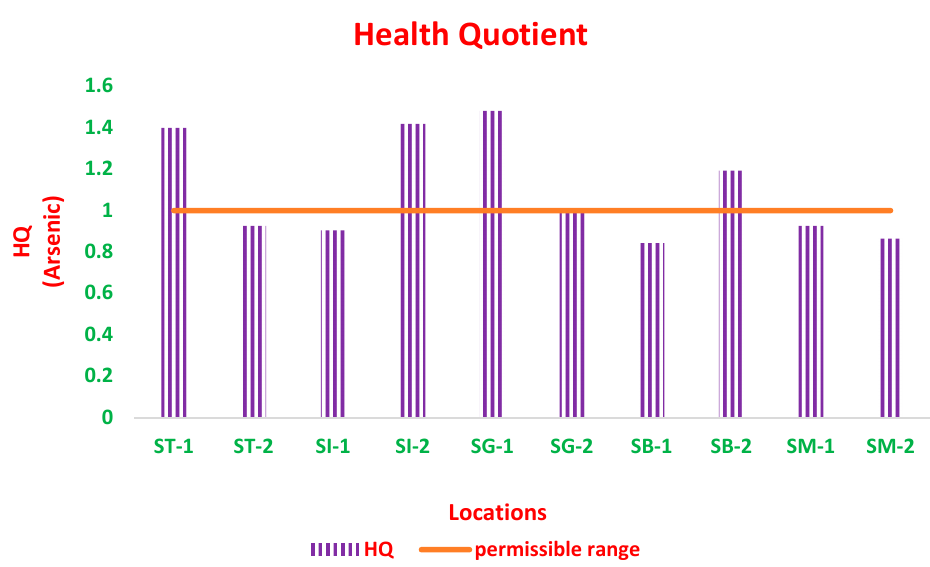
Figure 5. Health quotient in different areas of Lahore, Pakistan.